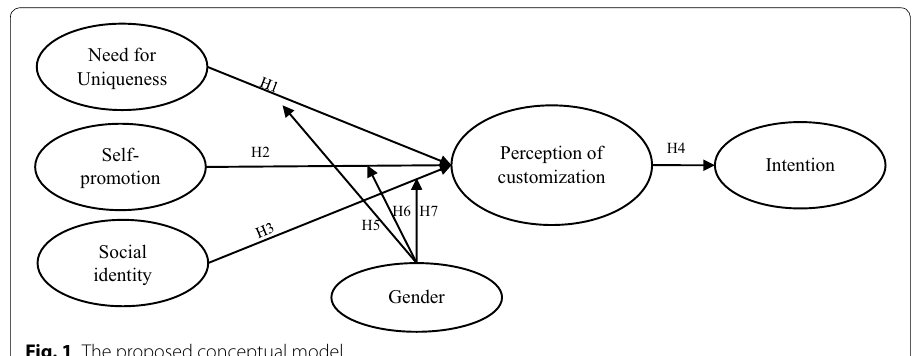
Fig. 1 The proposed conceptual